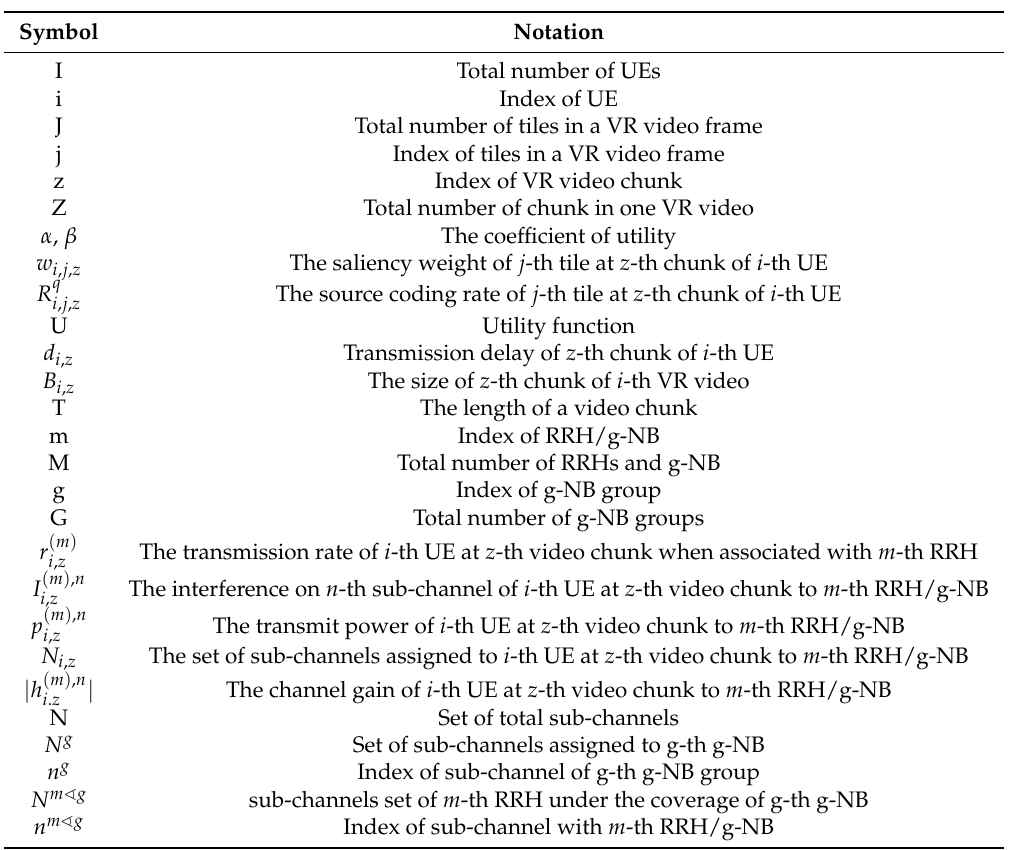
Table 1. Symbols and